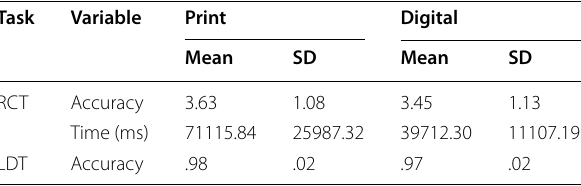
Table 1 Descriptive analysis on the three variables of interest: comprehension (over 5 points), word recognition accuracy (over 1 point), and reading time in milliseconds